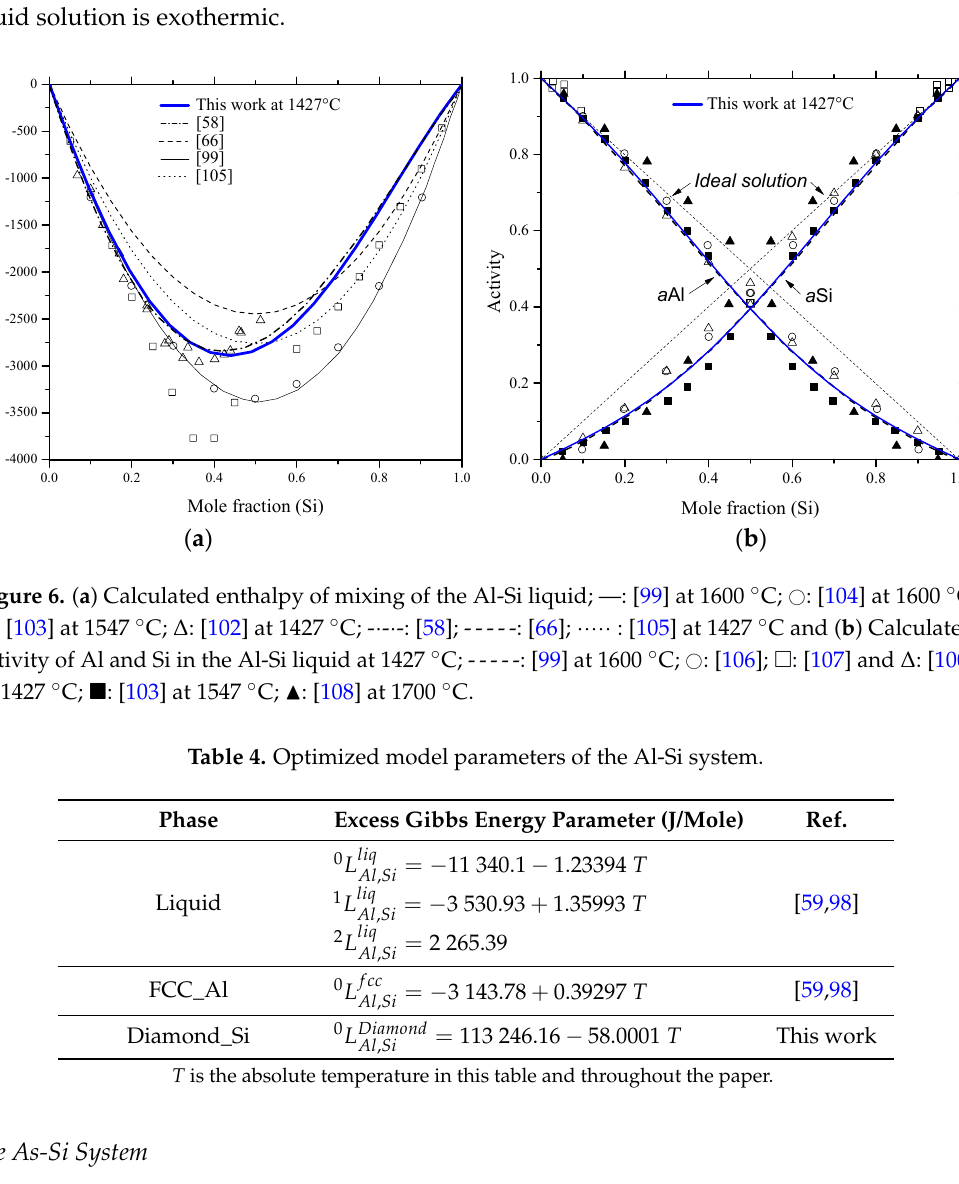
T is the absolute temperature in this table and throughout the paper.